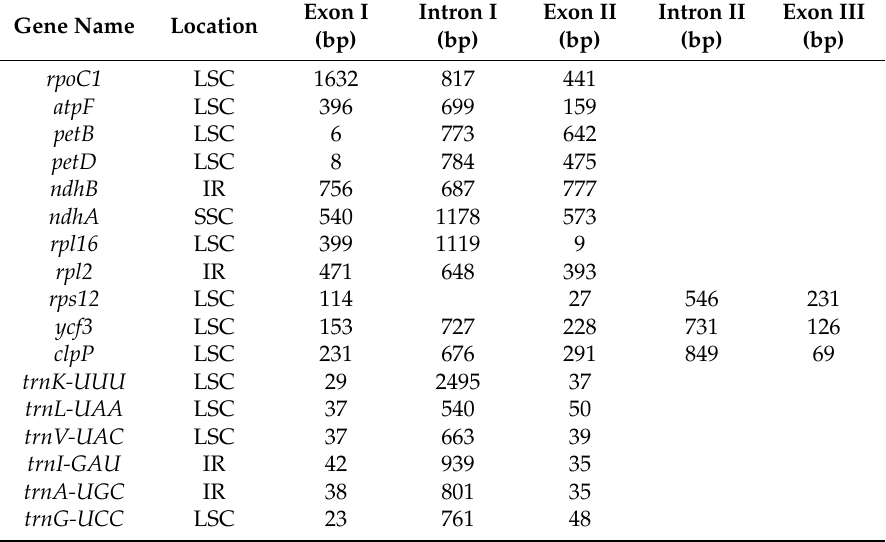
Table 4. Genes with intron and their length of exons and introns in plastid genome of C. edulis